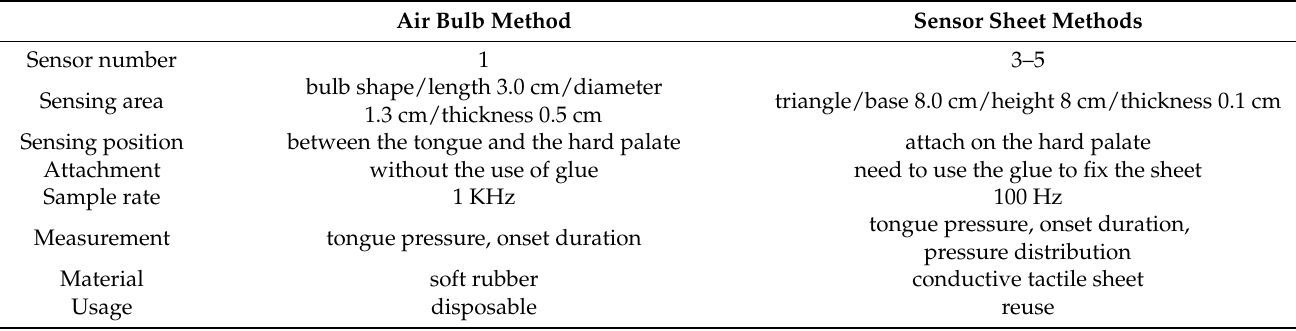
Table 13. Comparison between the air bulb method and the sensor sheet